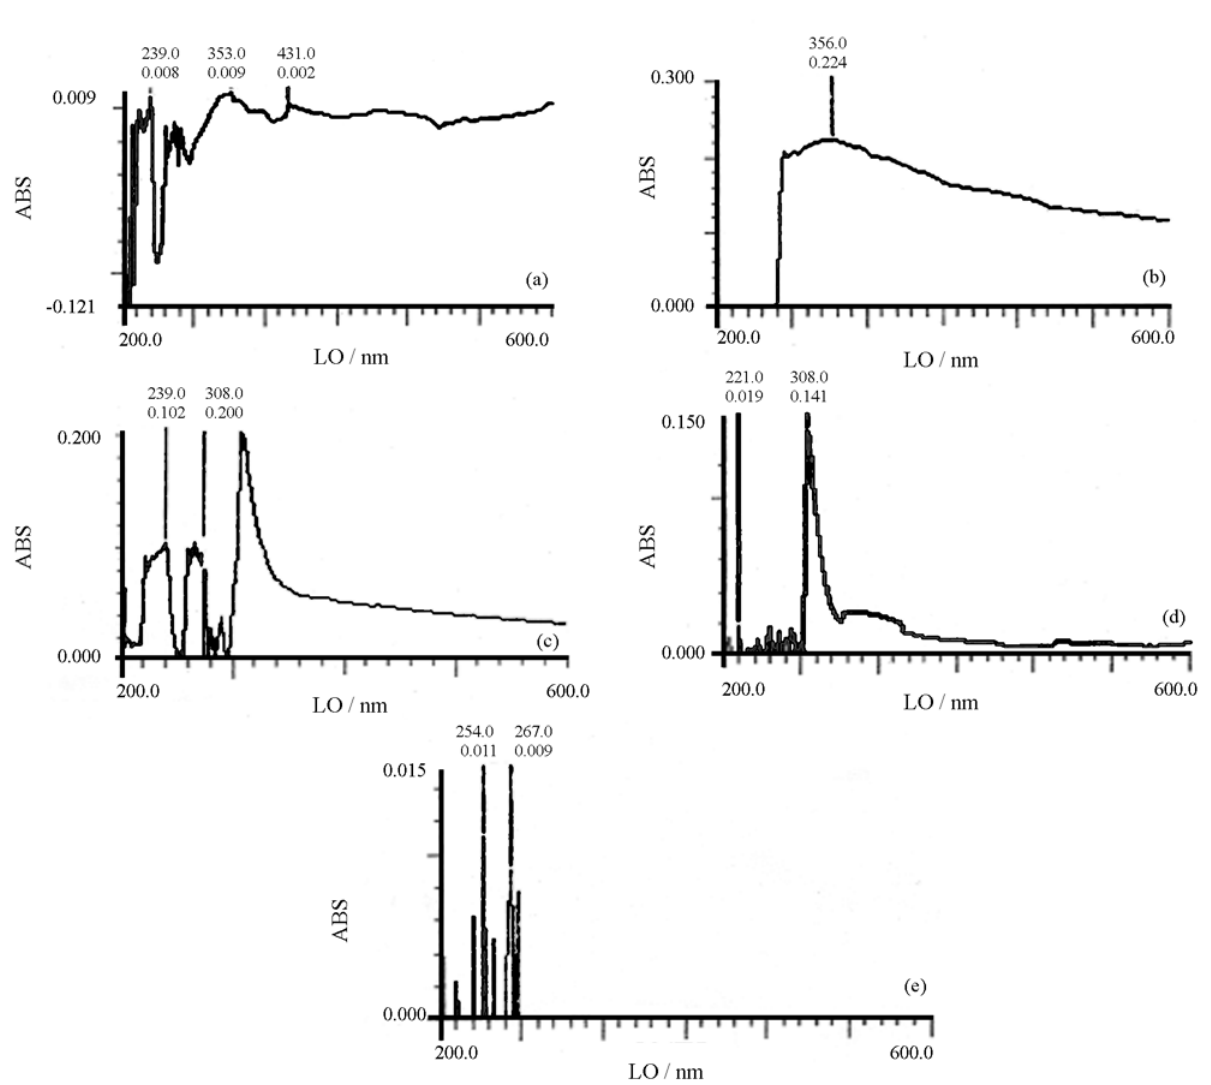
Figure 4. Espectros de UV-visible característicos de una disolución de Al 2 (SO 4 ) 3 0.1 molar, correspondientes a muestras líquidas obtenidas del filtrado del sistema Al 2 (SO 4 ) 3 - NH 4 OH - H 2 O a diferentes valores de pH: (a) pH 3, (b) pH 7.7 y (c) pH